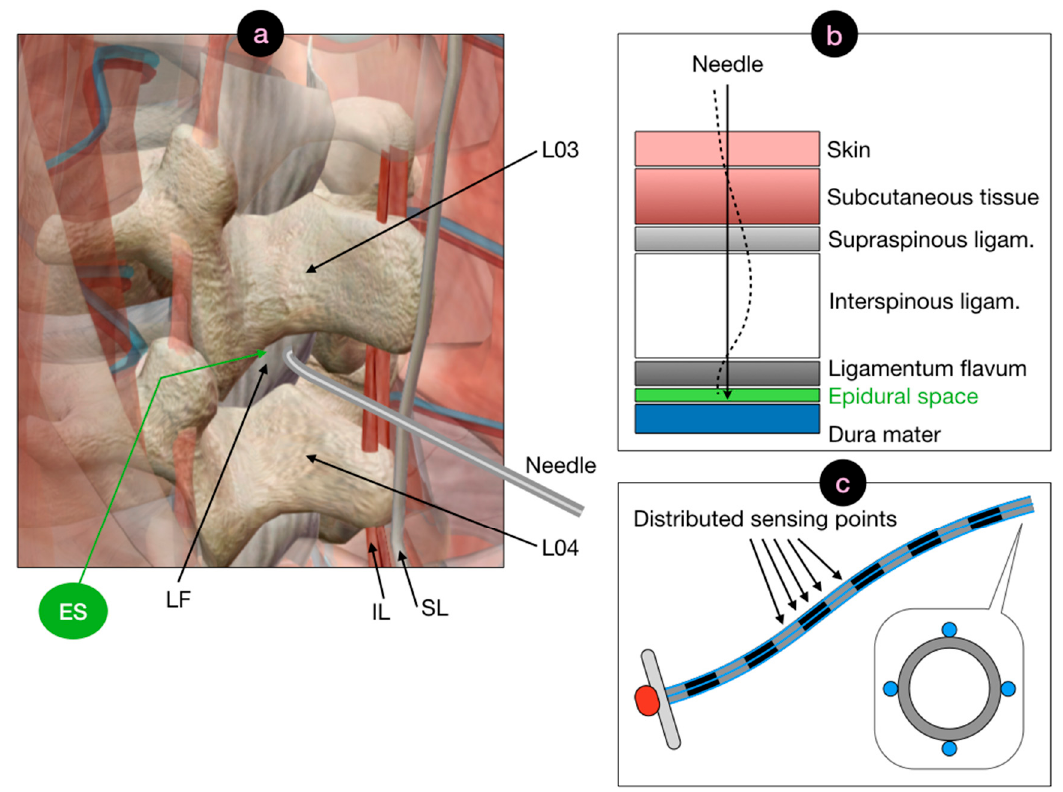
Figure 1. Rationale of the proposed method for guidance of the epidural anesthesia. ( a ) Anatomical view of the epidural space (ES), located behind the ligamentum flavum (LF) located between L03 and L04 vertebrae. The needle pierces the skin, crossing the subcutaneous fat layer, and progresses through layers of skeletal tissues such as supraspinous ligament (SL), interspinous ligaments (IL) located in proximity of the interspinales lumborum, and finally crosses the hard LF tissue. ( b ) Sequential view of the tissues penetrated by the epidural needle from the outer skin to the epidural space. As the needle progresses through tissues with different stiffness, it tends to bend into different patterns. The shape-sensing method reconstructs the needle silhouette and guides the insertion through the ES. ( c ) Overview of the method for shape sensing. Four fibers are mounted externally to the needle in the east, north, west, south cardinal points recording distrib- uted strain patterns with millimetric spatial resolution.